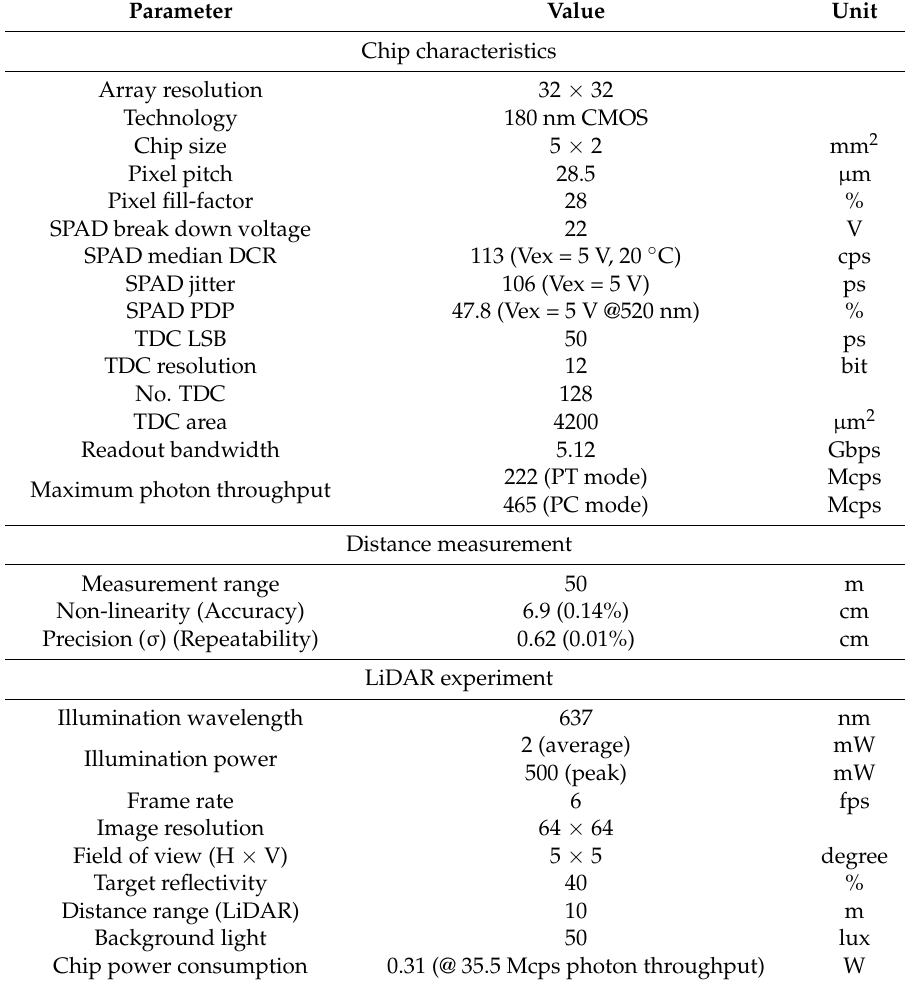
Table 2. Performance summary of the sensor and LiDAR